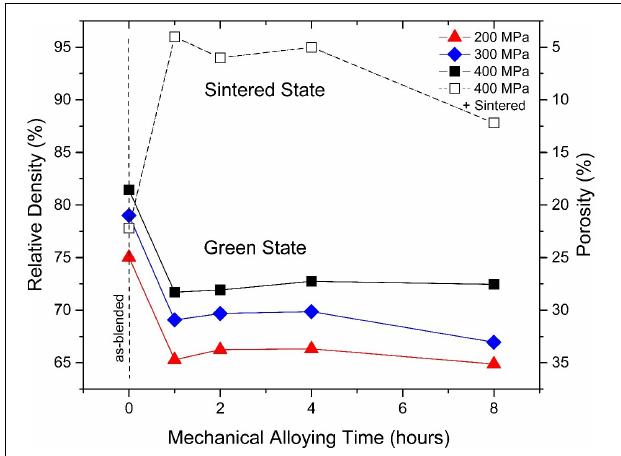
FIGURE 3 | Relative density and retained porosity values of the samples after compaction (green state) and after sintering (modified after Söyler et al.,